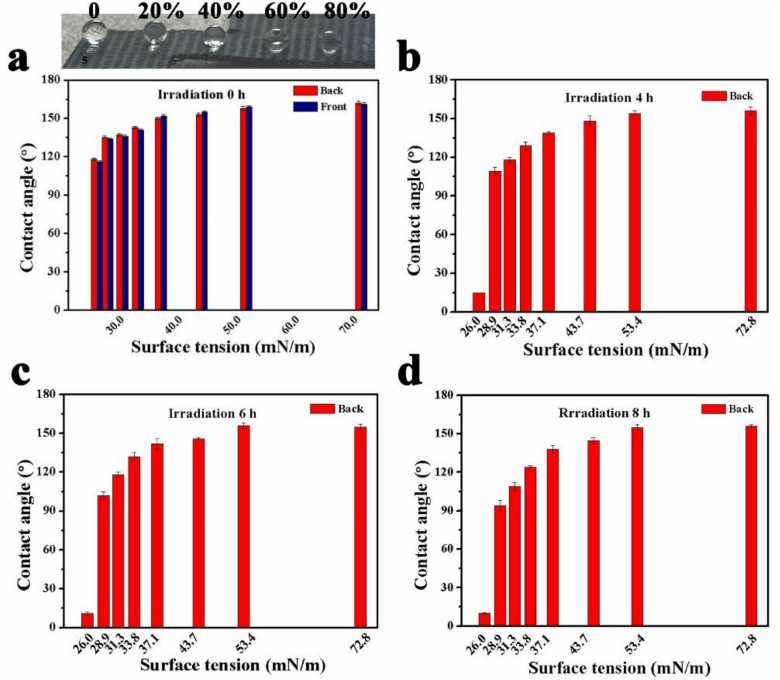
Figure 3. Water contact angle changes for ethanol–water mixtures with different surface tensions after UV irradiation for different times. Back: unirradiated side of the mesh. ( a ) is the changes of CAs on the two sides of the resultant Ti mesh for the liquid droplets with different surface tensions; the globular liquid droplets are seated on the Ti surface for the subfigure; ( b ) is the changes of CAs on the back side of the resultant Ti mesh for the liquid droplets with different surface tensions after irradiation about 4 h; ( c ) is the changes of CAs on the back side of the resultant Ti mesh for the liquid droplets with different surface tensions after irradiation about 6 h; ( d ) is the changes of CAs on the back side of the resultant Ti mesh for the liquid droplets with different surface tensions after irradiation about 8